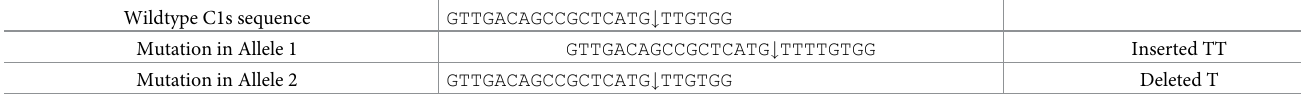
Table 4. C1s allele sequences for C1s -/- CHOK1 clone 2.E7. Wildtype C1s